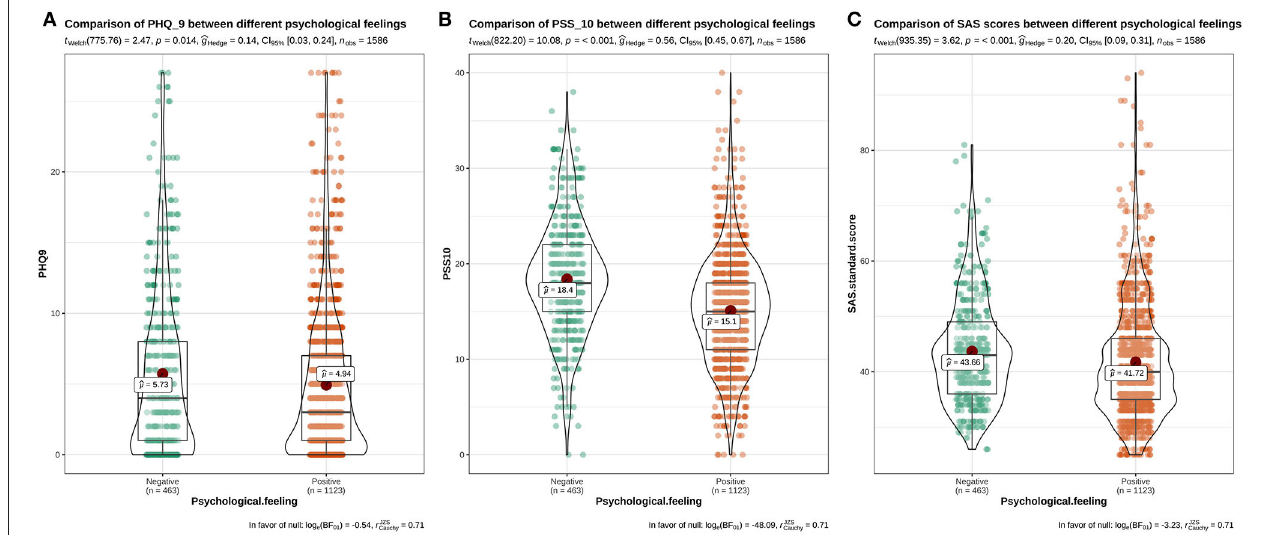
FIGURE 6 | The distribution maps of PHQ-9, PSS-10, and SAS scores of students with different psychological experiences (negative and positive). (A) Distribution of PHQ-9 scores in different psychological experiences; (B) Distribution of PSS-10 scores in different psychological experiences; (C) Distribution of SAS scores in different psychological